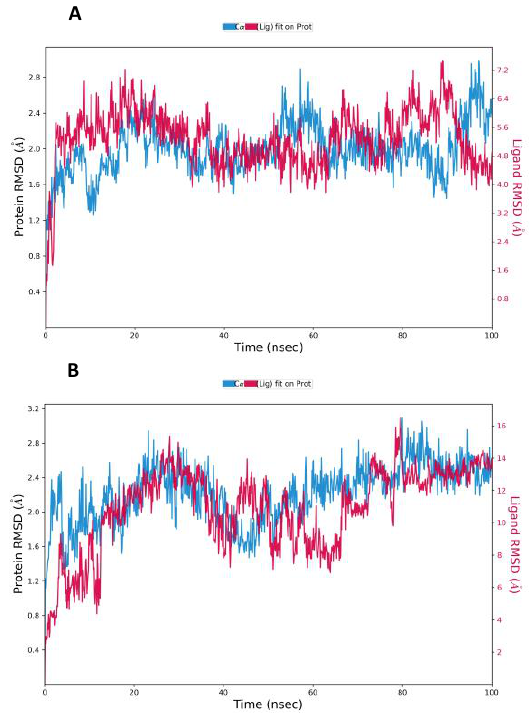
Figure 4. The root-mean-square deviation (RMSD) of the C α atoms as a function of 100ns simulation time for the ligands with Mpro ( A ) 25-hydroxy vitamin D ( B ) Lopinavir. Small, globular proteins can tolerate RMSD values with a change of 1–3. Lopinavir was used as a trial benchmark for the previously mentioned medication candidate. The evidence from the RMSD for 25-hydroxy vitamin D and Lopinavir during the MD run indicates that the values fall within acceptable limits, and as a result, the simulation is equilibrated. Throughout the simulation, protein interactions with the ligand can be visualized. The average RMSD value was found to be less than 2 in both protein and ligand. A significant difference was observed between the average RMSD value of protein and ligand. The plot shows that these interactions can be summarized and grouped by type (Figure